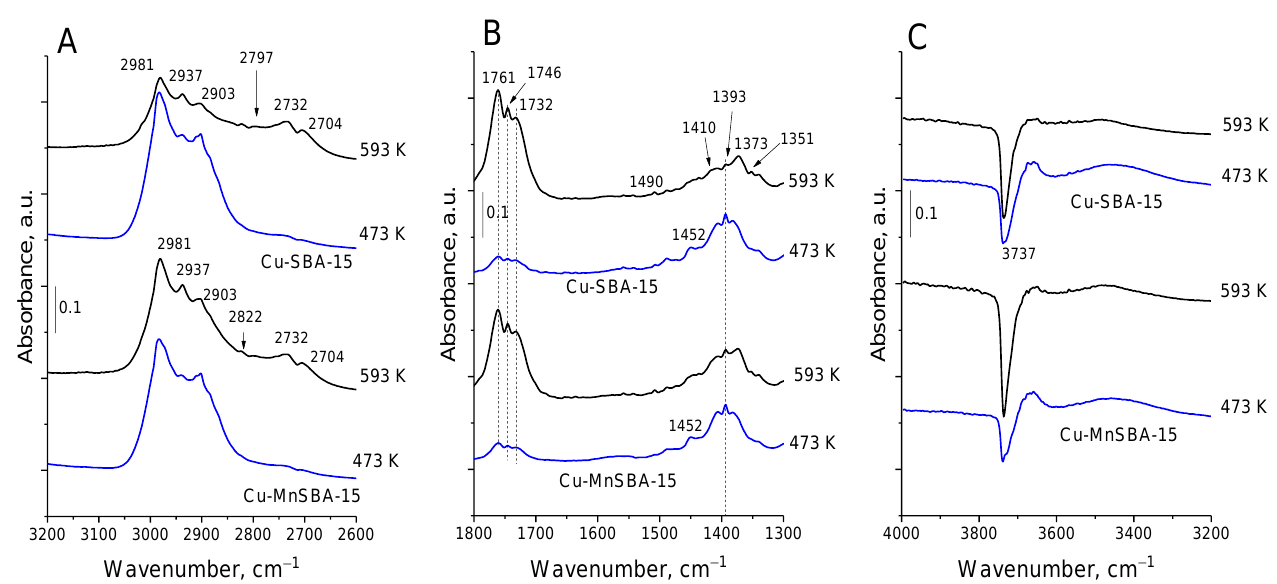
Figure 8. FTIR spectra recorded in ethanol flow at 473 K (blue) and 593 K (black) after 45 min of the dehydrogenation reaction for Cu-SBA-15 and Cu-MnSBA-15 materials: ( A ) 3200 – 2600 cm −1 range; ( B ) 1800 – 1300 cm −1 range; ( C ) 4000 – 3200 cm −1 range.